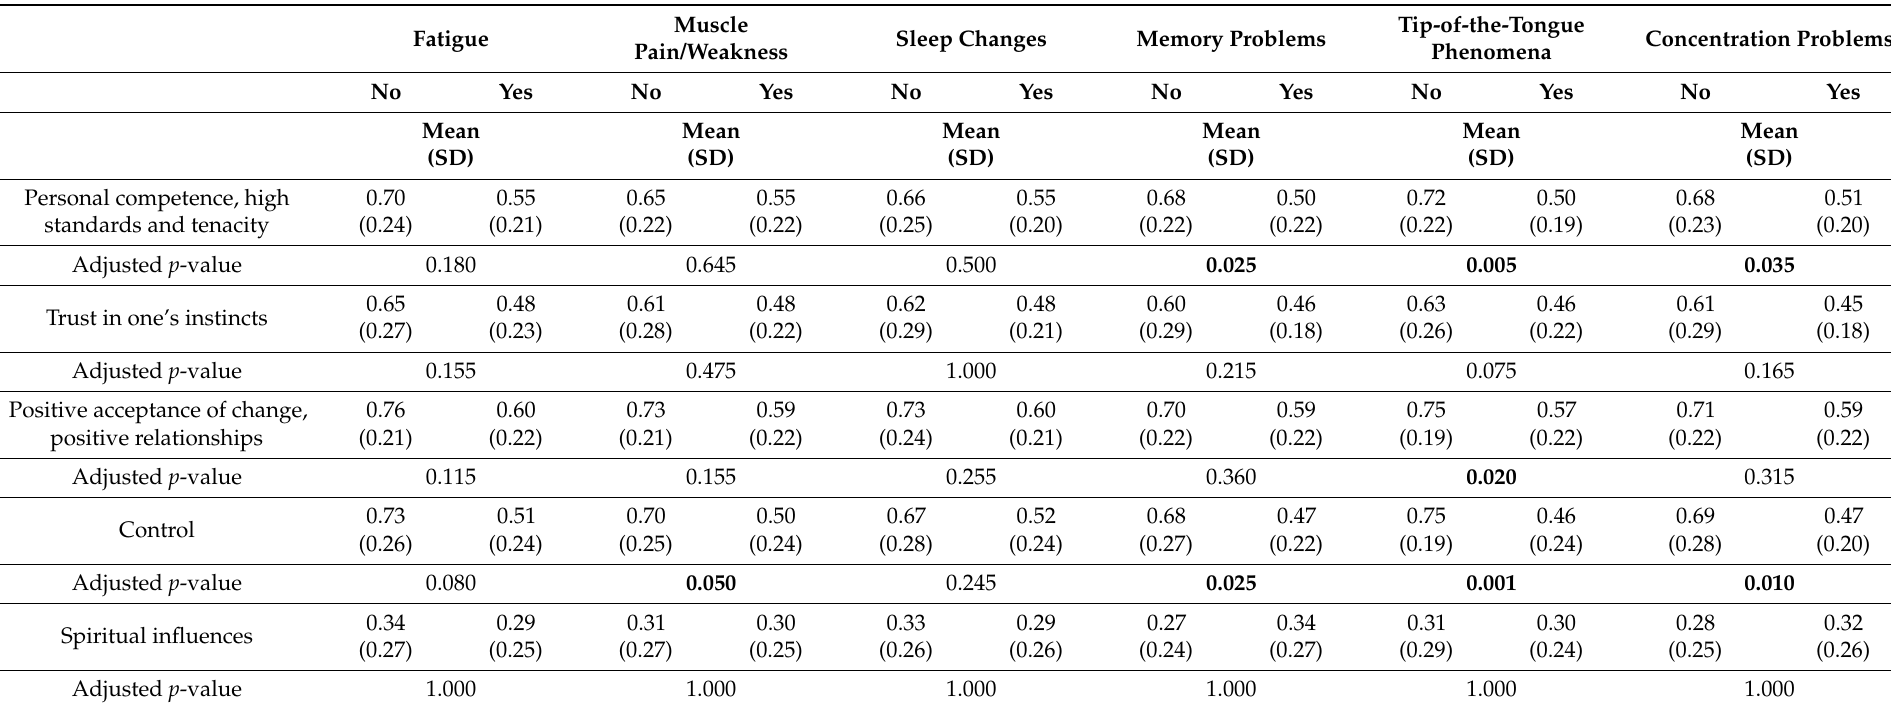
Table 3. Differences in resilience factors based on presence of persisting